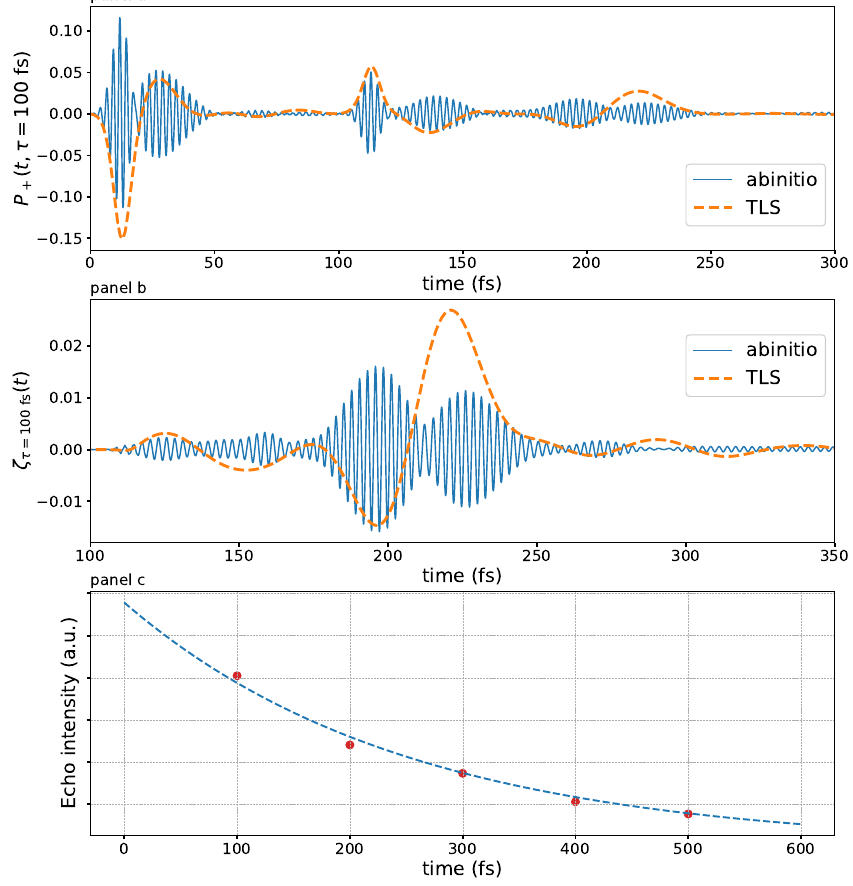
Figure 5: Real-time behavior of polarization and echo signals in the high-fields regime. (a) Time dependent polarization generated by a perturbing field with posi- tive phase α = 1 (see Eq. (1)). The ab initio result (blue continuous line) is compared with the TLS simulation (orange dashed line). (b) Echo signal defined in Eq. (4). Same convention as panel (a). (c) Time integrated intensity of the ζ τ for different values of τ (red dots) as a function of t = 2 τ compared with the an exponential func- = 250fs. A fit is performed tion Ae − t / T 2 (blue dashed line), with dephasing time T 2 to optimize the amplitude A . The plot shows that the echo signal time decay is not affected by the FPD